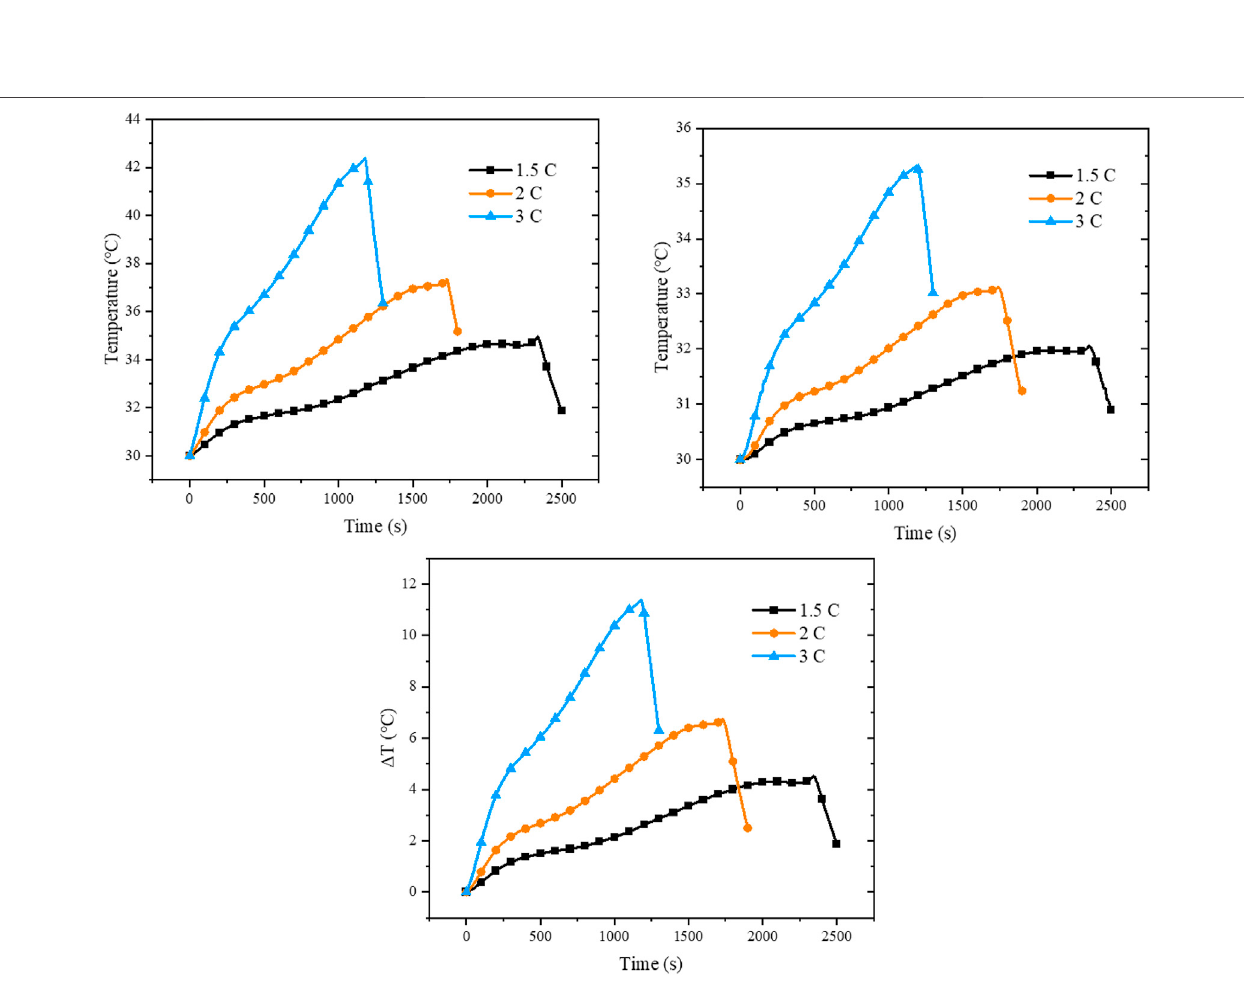
FIGURE 6 | Temperature of the battery pack at different discharge